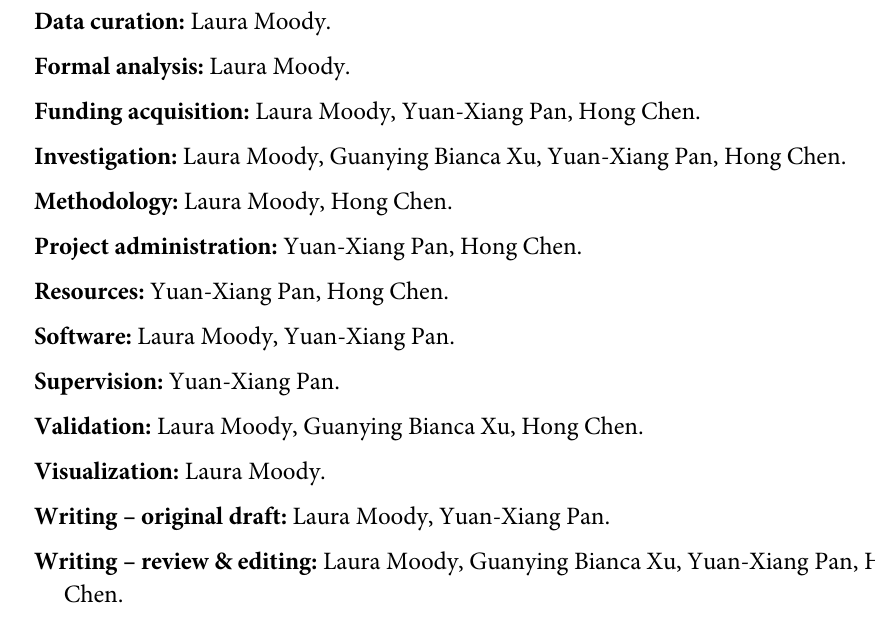
S8 Fig. miR-105 and miR-767 expression across cell lines. (A) miR-105 and (B) miR-767 expression levels were measured across 13 cell lines. (C) Expression was consistent with patient data, as miR-105 and miR-767 expression were highly correlated. (D) miR-105 and (B) miR- 767 expression was not correlated with miR-9 expression. S9 Fig. miR-105 and miR-767 do not alter expression of AKT isoforms or PI3K subunits. A549 cells were treated with a negative control miRNA (Control), miR-105 and miR-767 (miR), ZSTK474 alone, or ZSTK474 and miR-105/767 (ZSTK474 + miR). Gene expression was measured by qPCR. Each treatment condition included three replicates. ANOVA was per- formed. The p-values for the main effect of miRNA and ZSTK474 as well as their interaction are reported. Data are normalized to L7a and presented as mean ±